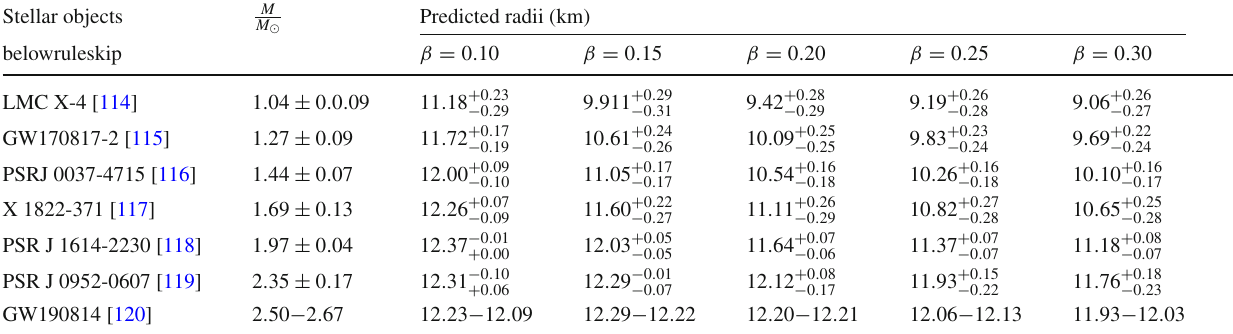
Table 3 Numerical values of the predicted radii of different stars for Solution 5.2 with surface density ρ s (cid:12) 6 × 10 14 gm / cm 3 , A = 0 . 0078 , B = 0 . 0093 ,α = 1 .